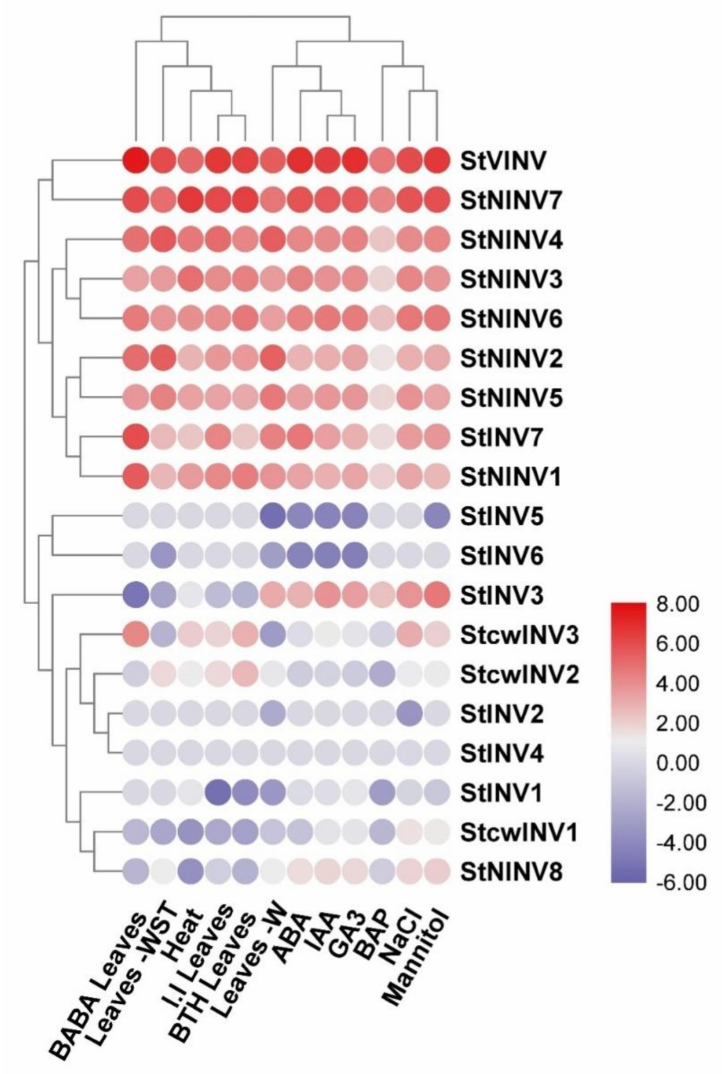
Figure 8. Heat map showing expression profile of invertase genes under different biotic and abiotic stresses in Solanum tuberosum . The short forms used are BAP: 6-benzylaminopurine6- benzylaminopurine, IAA: indole acetic acid, GA3: gibberellic acid, BABA: beta amino butyric acid, BTH: